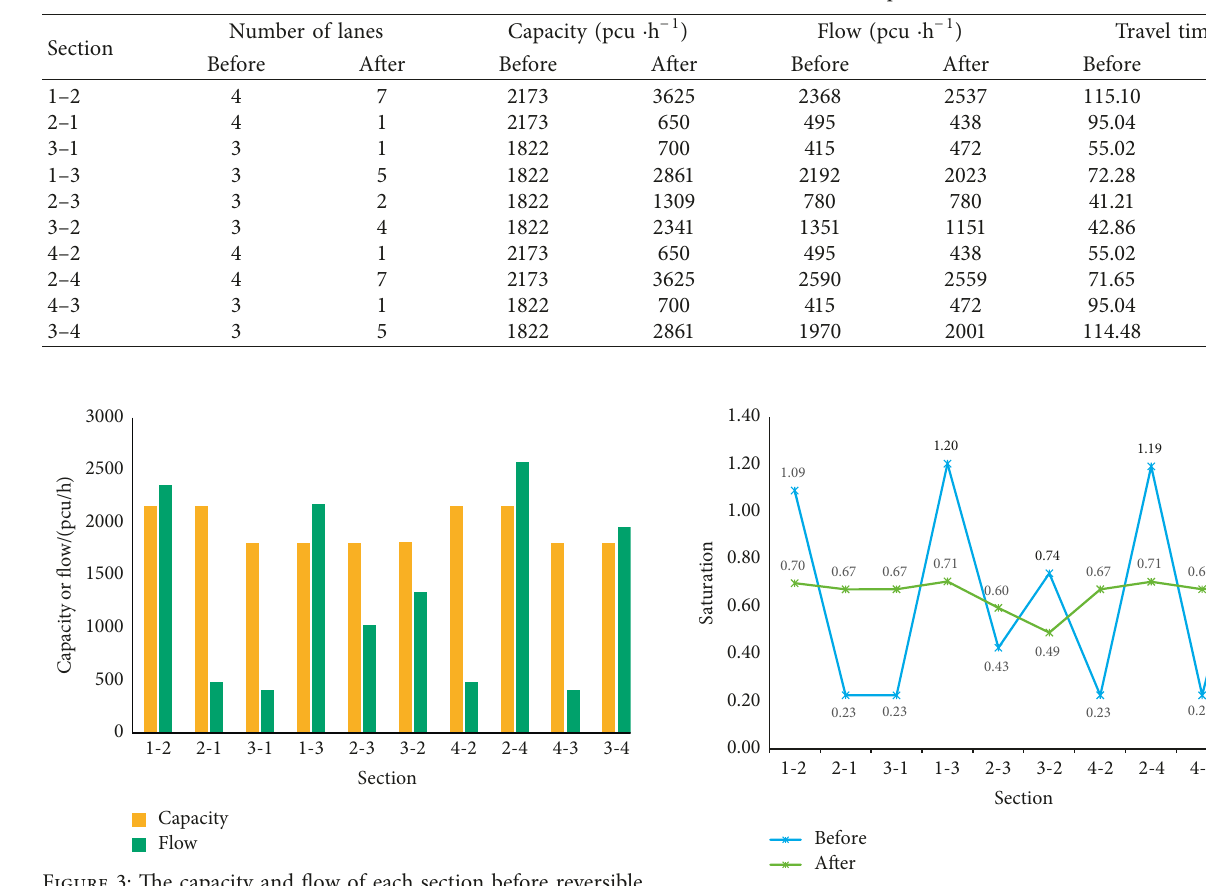
Figure 5: Saturation of sections before and after optimization.